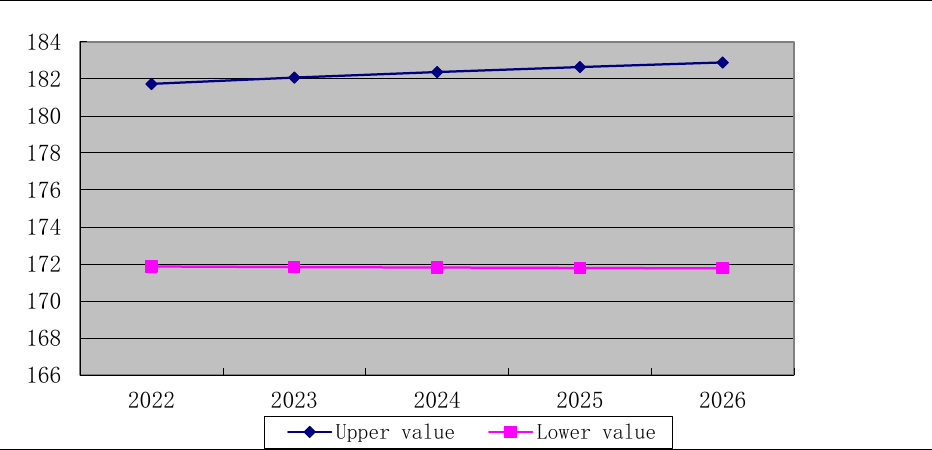
Figure 11. The variation interval of water requirement with the influence of the secondary industry in Hebei.